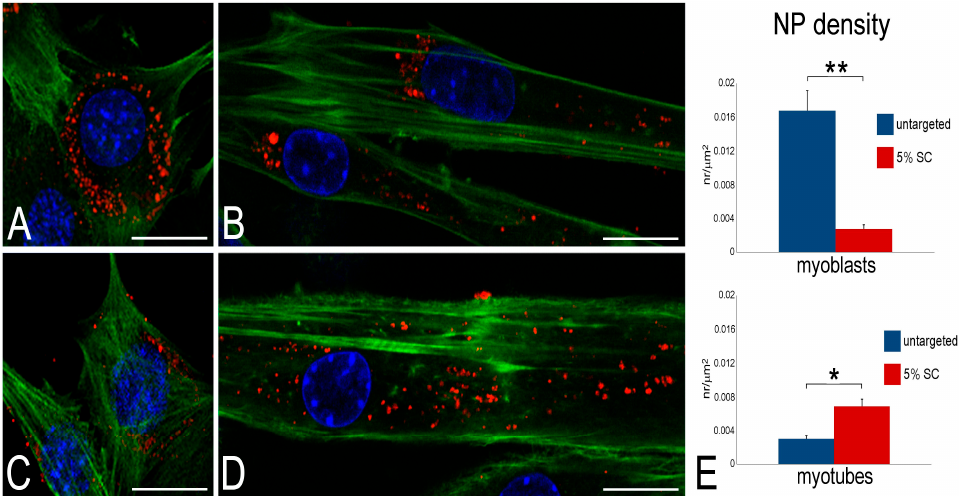
Figure 4. ( A ) CFM micrographs of myoblasts ( A , C ) and myotubes ( B , D ) incubated with untargeted nanoparticles ( A , B ) and 5% SC-associated nanoparticles ( C , D ). Nanoparticles are loaded with Nile Red (red), cells are stained with phalloidin (green) and nuclei with Hoechst 33,342 (blue). Bars, 20 µm. ( E ) Quantitative evaluation of internalized nanoparticles; data are given as mean values ± SEM. ** p < 0.001; * p < 0.01.